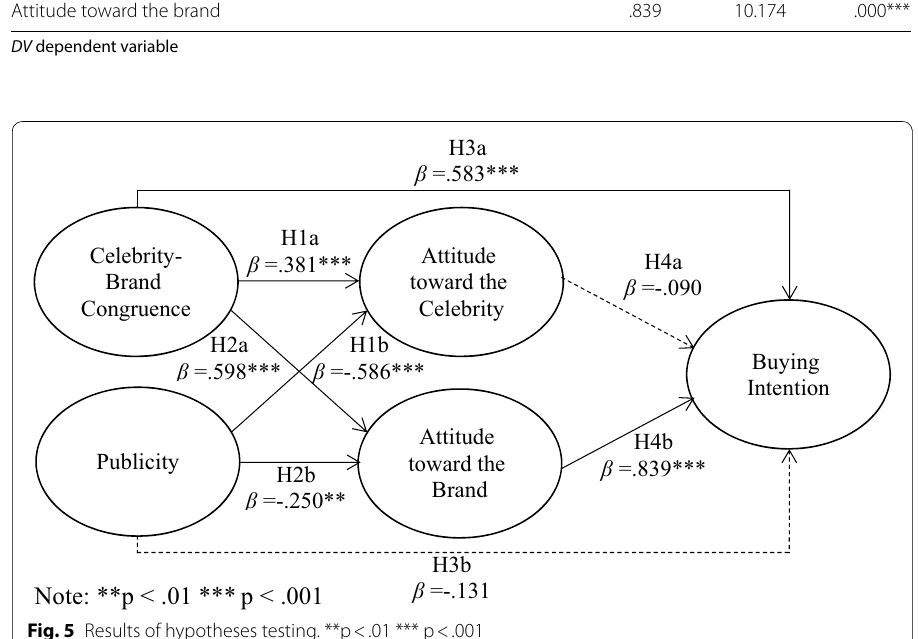
Fig. 5 Results of hypotheses testing. **p < .01 *** p <